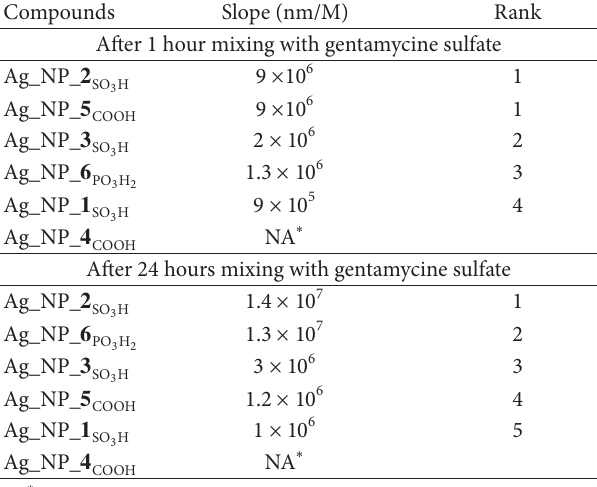
T 3: e slopes of the variation of the maximum wavelength of Ag_NP_Calix[ ]arene against the concentration of gentamycine sulfate. 𝑛𝑛 Compounds Slope (nm/M) Rank Aer 1 hour mixing with gentamycine sulfate